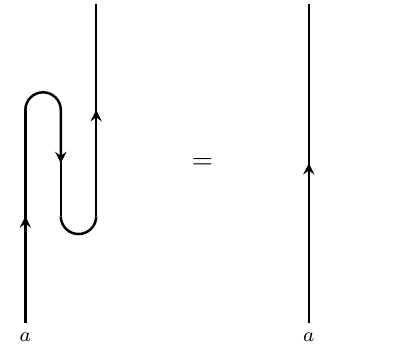
Figure 5 . Consistency condition on evaluation and co-evaluation morphisms resulting from a topological